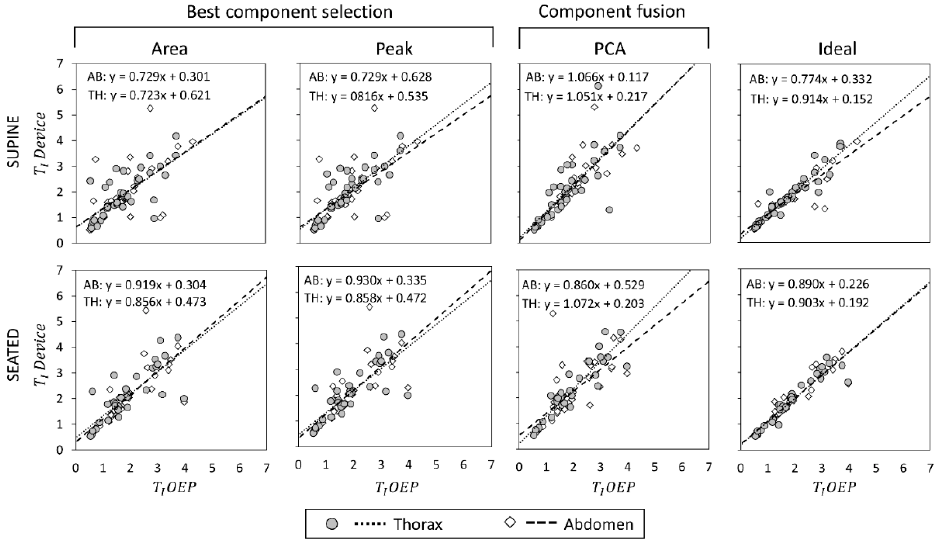
Figure 6. Comparisons of inspiratory time (T I expressed as seconds) measurements by using the proposed device and by using Optoelectronic plethysmography (OEP) presented as regression analysis, in supine (top panels) and seated (bottom panels) positions. For what concerns T I measurements obtained with the IMU-device, three dimension-reduction methods were considered: Area, Peak and PCA-fusion. The performance obtained by using these three methods is benchmarked against that obtained with the Ideal quaternion component determined a posteriori based on the minimum estimation error. The regression line between measurements done by OEP and the proposed device is plotted, and the relative equation presented, both for the thorax and the abdomen.